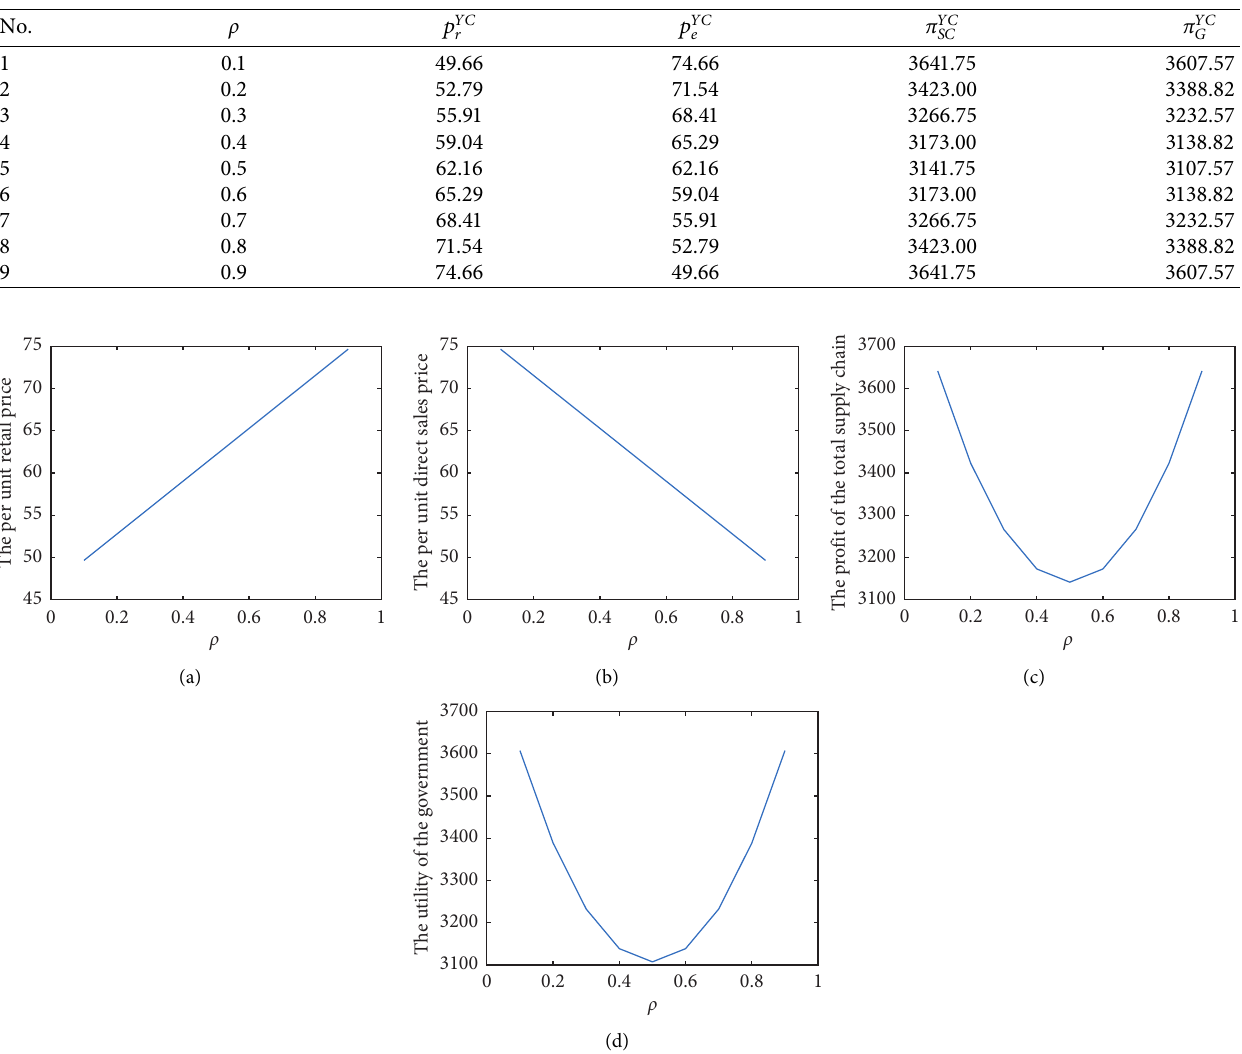
Table 3: The effect of the degree of consumer preference for the retail channel ρ based on centralized decision.